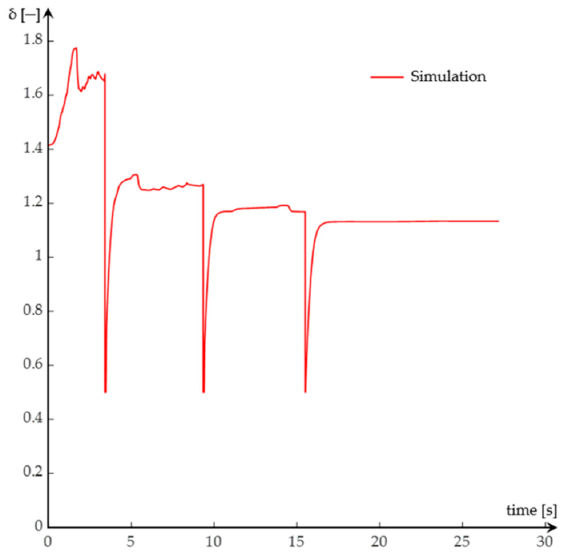
Figure 11. Modeling the mass moment of inertia coefficient.